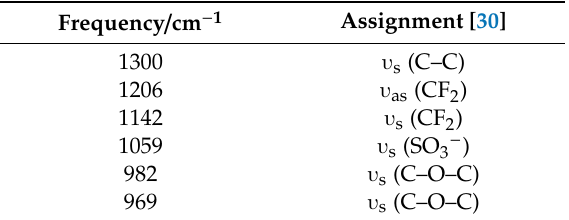
Figure 2. Infrared spectra of a Nafion membrane and CTO powder. Table 3. Main vibrational modes of